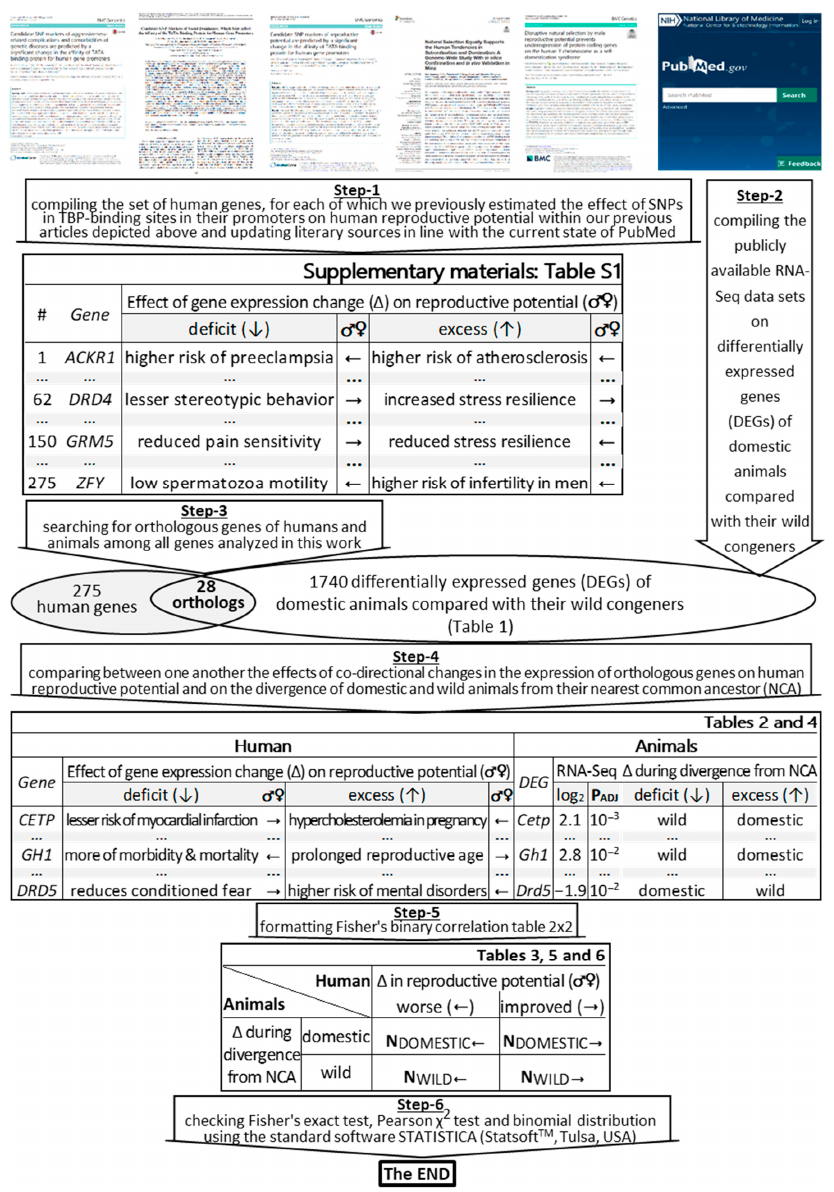
Figure 1. An algorithmic flow chart of the bioinformatics model of human diseases on the basis of differentially expressed genes (of domestic versus wild animals) that are orthologs of human genes associated with reproductive potential changes. Legend: Δ , gene expression change: deficit ( ↓ ), excess ( ↑ ); ♂♀ , reproductive potential change: worse ( ← ), improved ( → ); NCA, nearest common ancestor; P ADJ , significance (Fisher’s Z-test with those corrections on multiple comparisons, which are available within the RNA-Seq data, as published by their authors [26,28,29]).